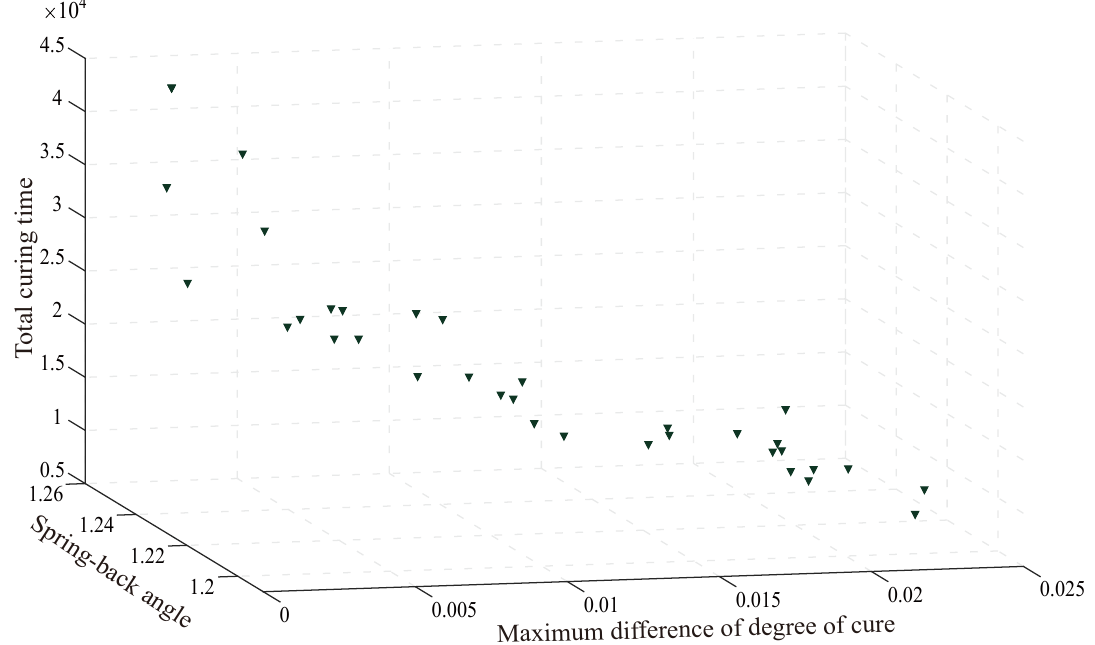
Figure 10. Three-dimensional scatter plot of the Pareto front of the multi-objective optimization result.